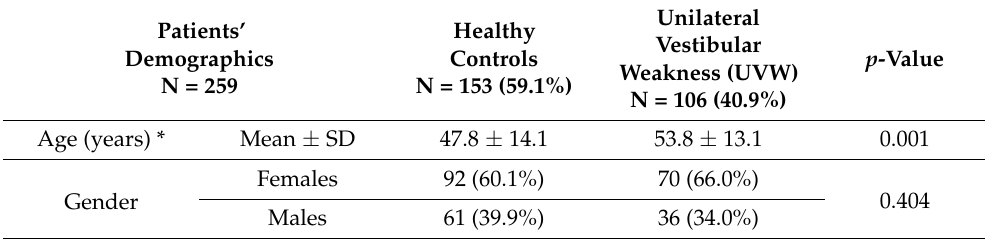
Table 1. Descriptive analysis for baseline patients’ demographic.